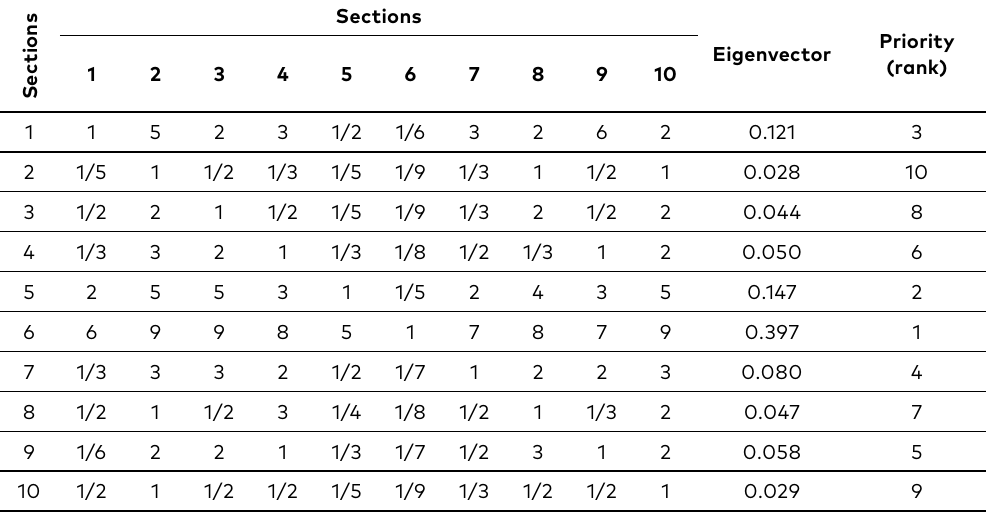
Table 9. Pairwise comparison of the accident sections concerning the total number of damaged vehicles